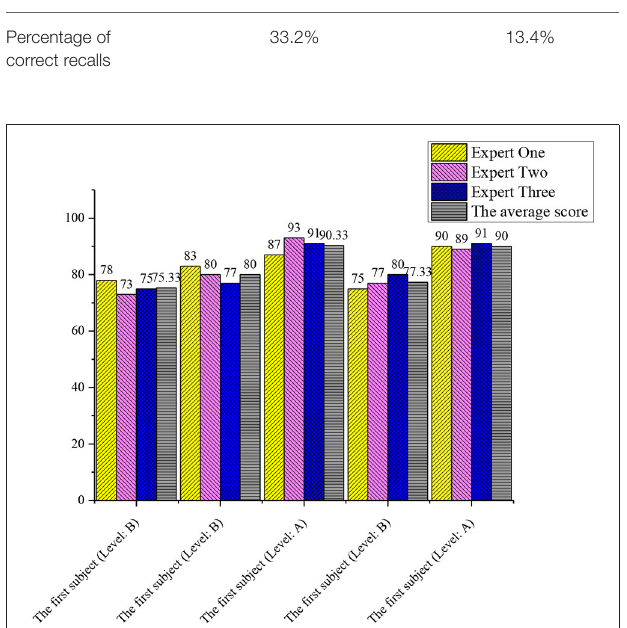
FIGURE 8 | Experts scoring the records in the cloud intelligent classrooms.